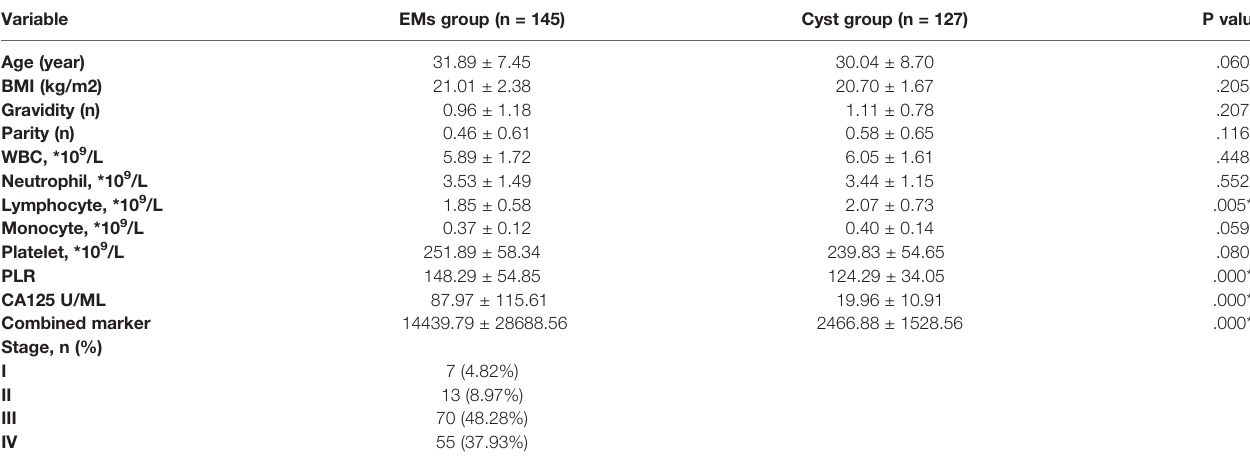
TABLE 1 | Comparison of Characteristics Between the EMs group and Cyst group.